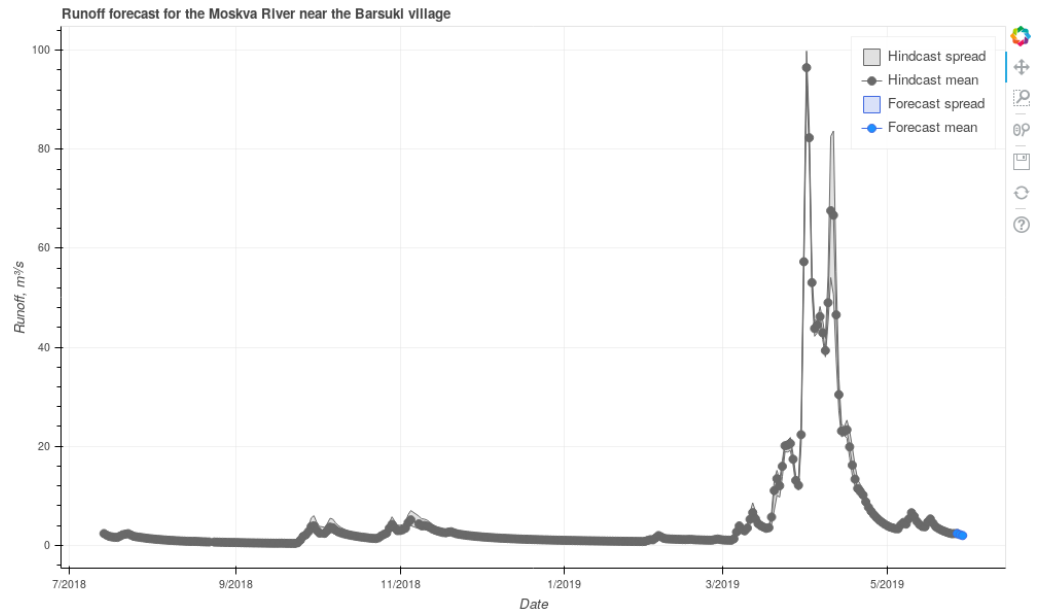
Figure 10. Screenshot of OpenForecast website with the runoff forecast for Moskva R. at Barsuki (https://hydrogo.github.io/openforecast/barsuki.html, 27 May 2019).